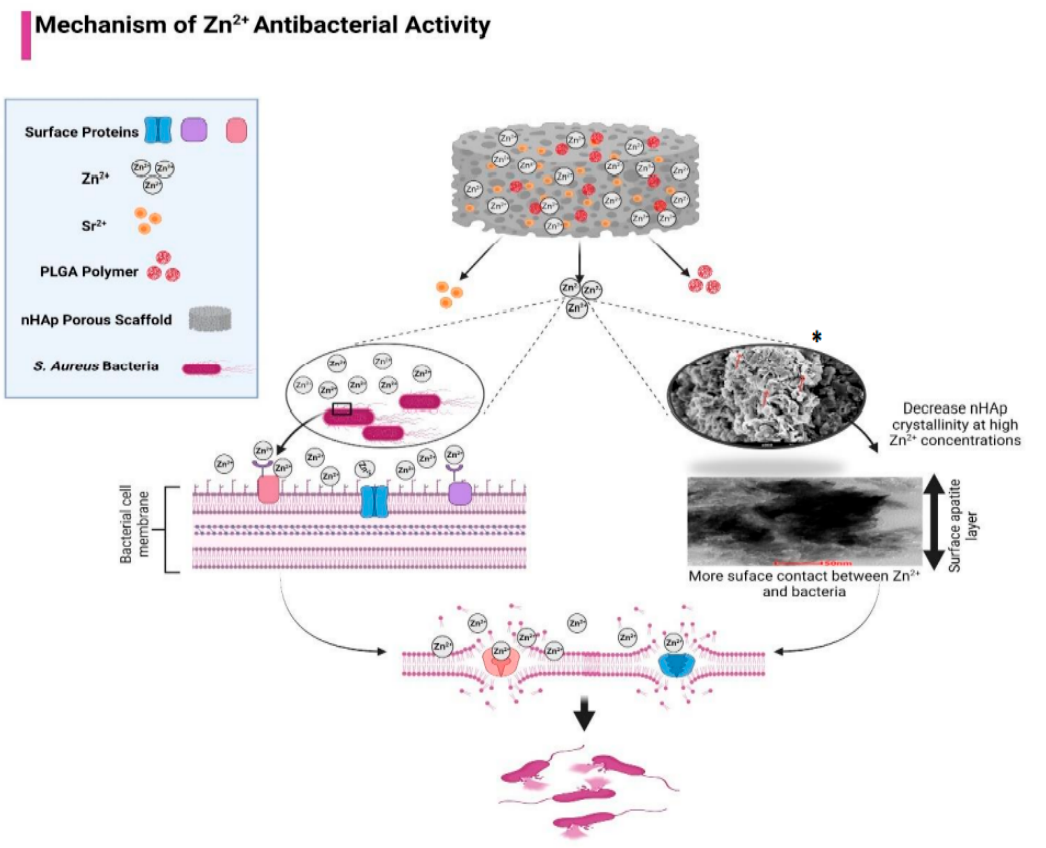
Figure 5. Mechanism of Zn 2+ antibacterial effect. Created with BioRender.com. * [59] Hassan et al.